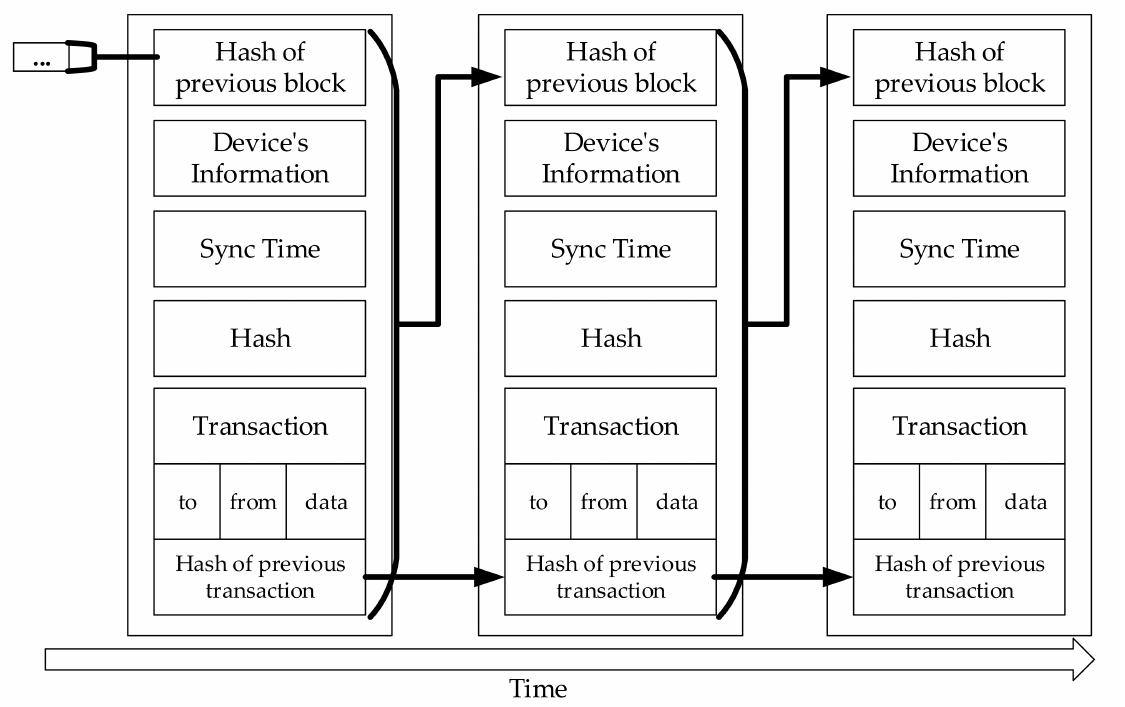
Figure 6. An example of the urgent sensed data blockchain.